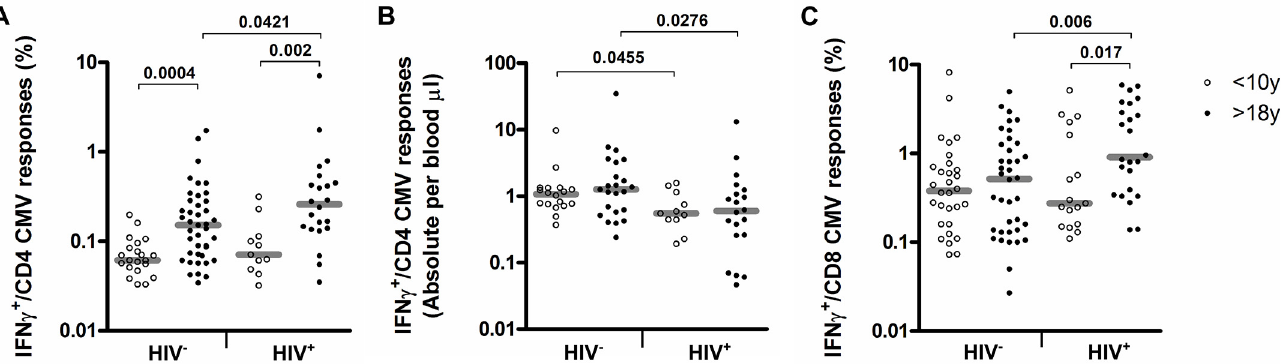
Fig 3. Frequencies and absolute counts of IFN γ + -CMVpp65 – specific CD4 + or CD8 + T cell in children below 10 years of age and adults. Scatter-plots depicting A) the frequencies or absolute counts of CMV specific IFN γ + -CD4 + T cells s and C) frequencies of CMV specific IFN γ + -CD8 + T cells in the two-age groups and according to HIV status.